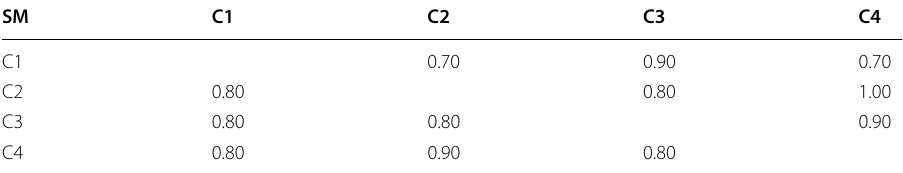
Table 9 Collective similarity matrix for revenue sharing